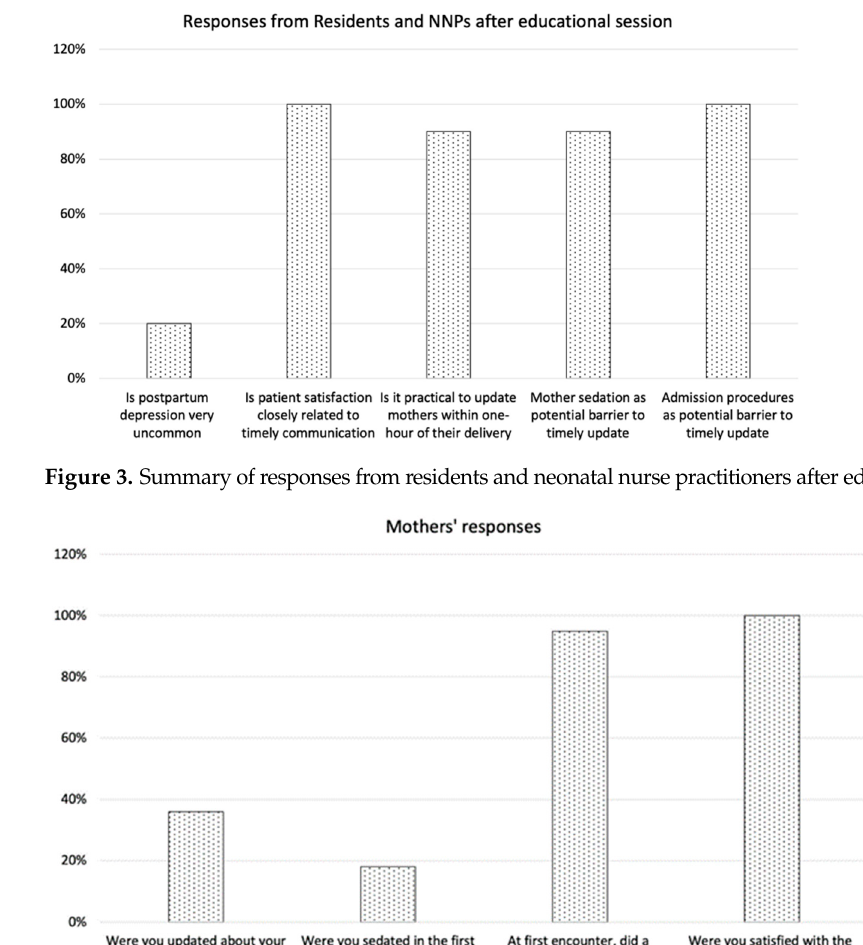
Figure 2. Distribution of update times (percentages).